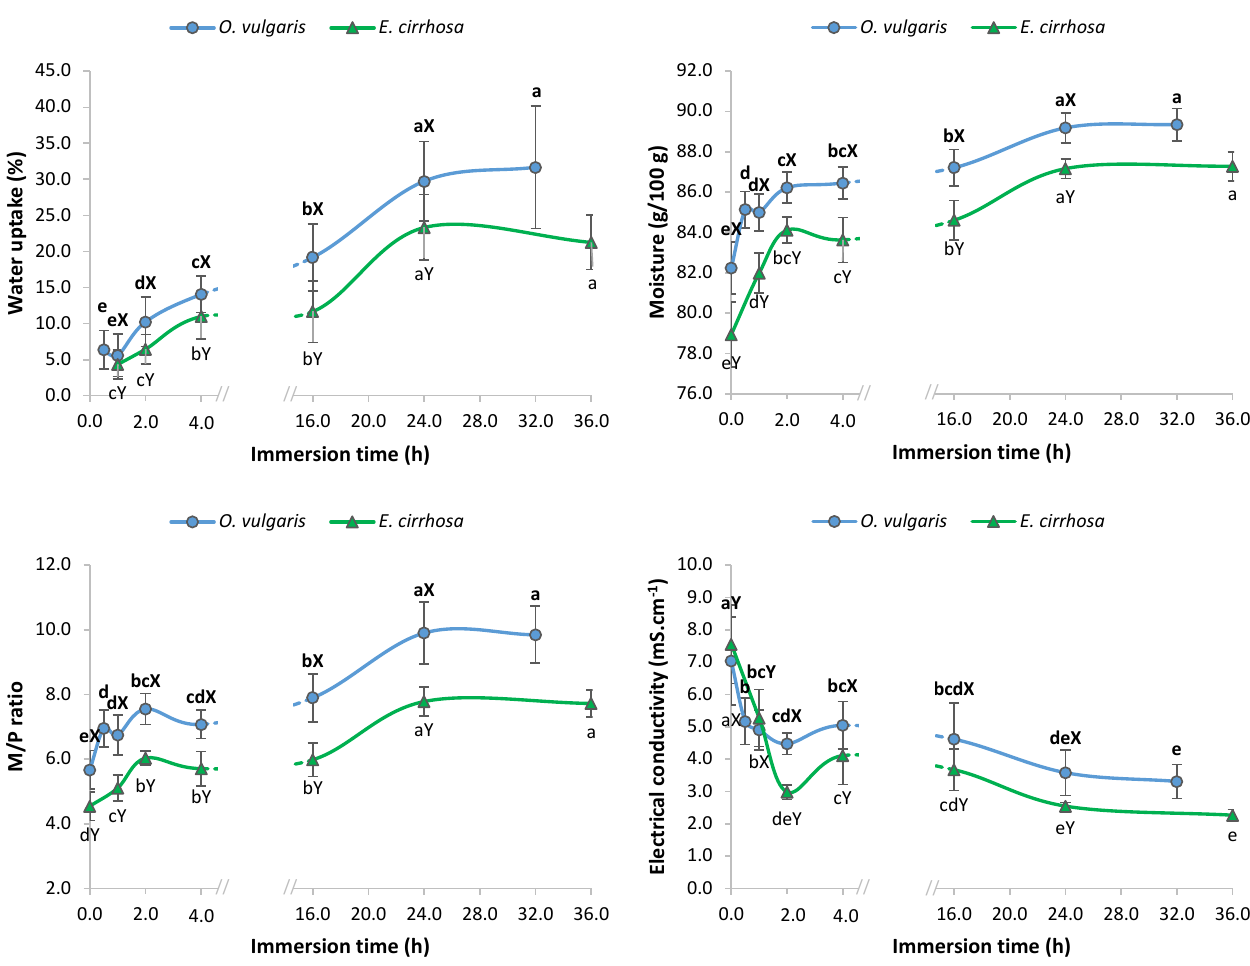
Figure 2. Effect of immersion time (0.5–36 h) in the water uptake, moisture content, moisture/protein (M/P) ratio, and electrical conductivity of Octopus vulgaris and Eledone cirrhosa . Different letters denote significant differences between species (X, Y) and different immersion time periods (a, b, c, ...) for each